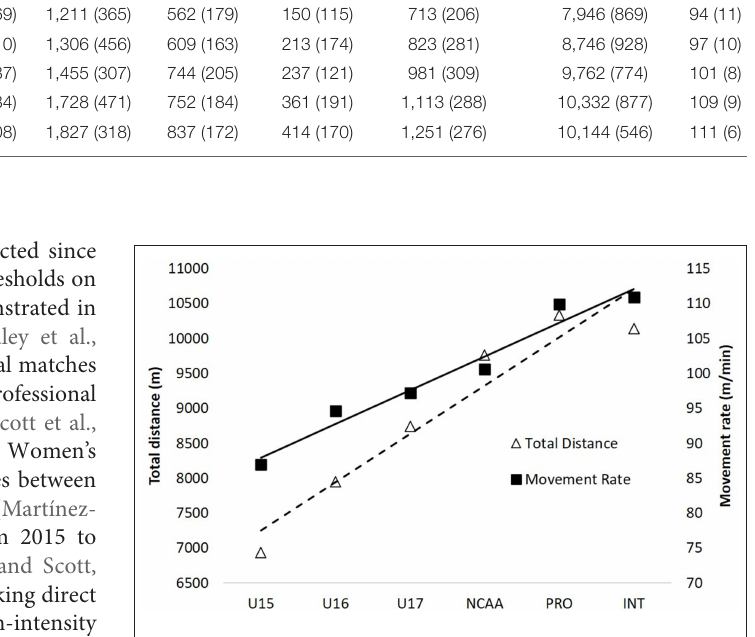
FIGURE 1 | Average total distance and movement rate across standards. Data from author